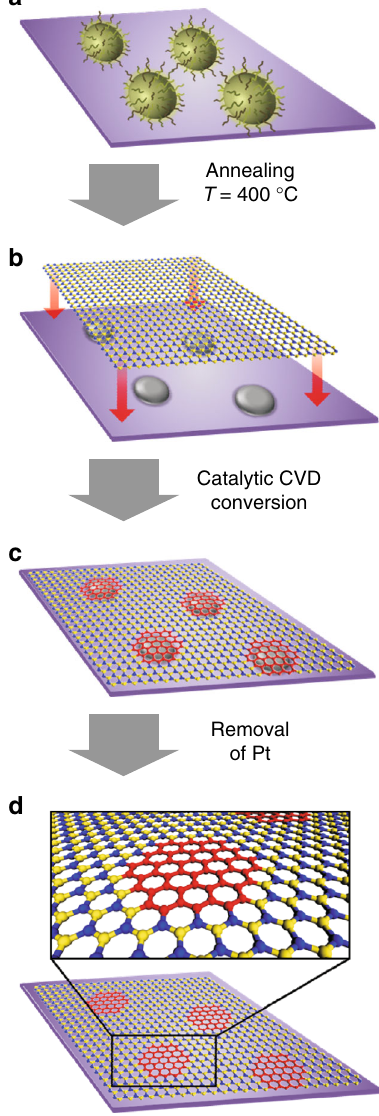
Fig. 1 The fabrication steps of GQD-hBN in-plane heterostructure based on hBN to graphene conversion catalysed by Pt NPs. a The self-assembly of diblock copolymer micelles PS-P4VP with H 2 PtCl 6 on Si/SiO 2 substrate. b Transfer of hBN monolayer on SiO 2 substrate covered by Pt NPs (blue spheres — boron atoms, yellow spheres — nitrogen). c Formation of the GQDs on top of an array of Pt NPs by catalytically assisted CVD (red spheres — carbon atoms). d The obtained in-plane GQD-hBN heterostructure after the removal of Pt